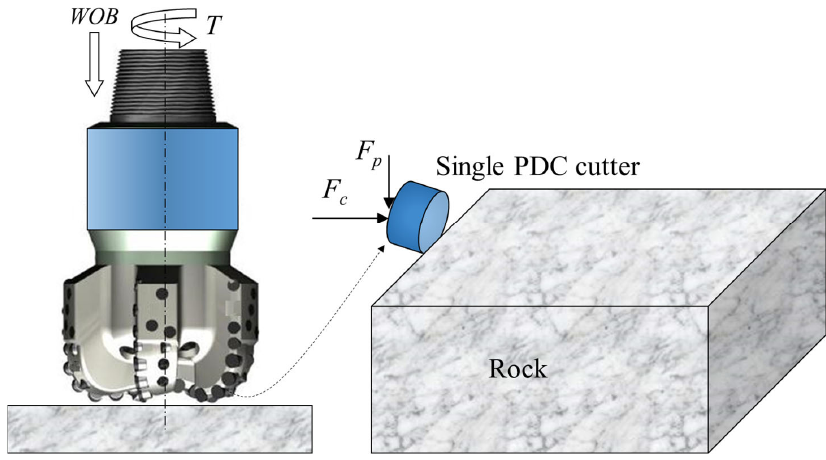
Figure 1. Rotary drilling with PDC cutters and the simplified problem involving a single cutter.